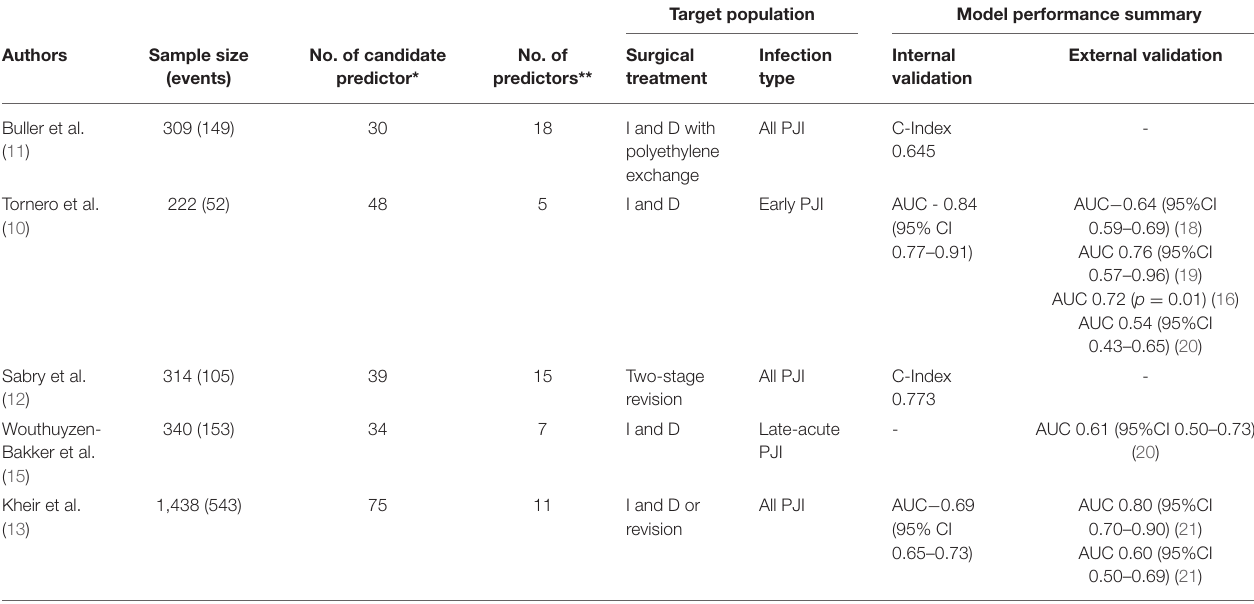
TABLE 1 | Five most widely cited tools to predict treatment outcomes of periprosthetic joint